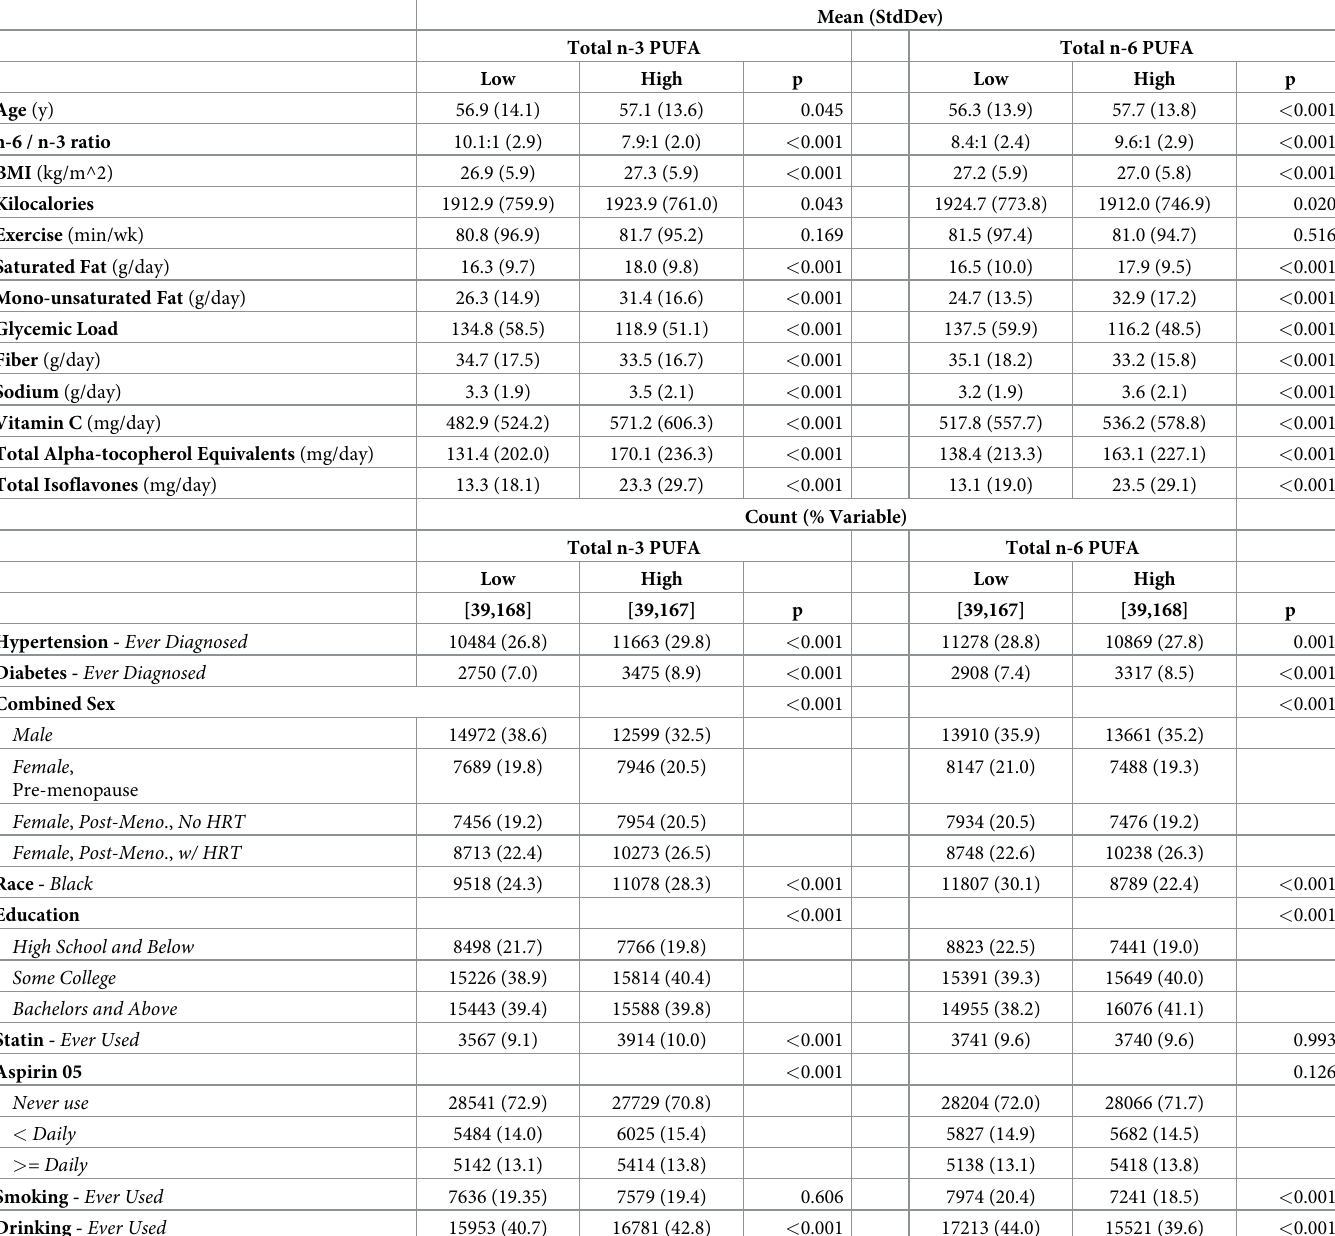
Table 1. Mean and standard deviation, or count and proportion, for demographic variables comparing those lower and higher than the medians of total n-3 PUFA or total n-6 PUFA (Chi-Squared and ANOVA p-values for comparison within fatty acid